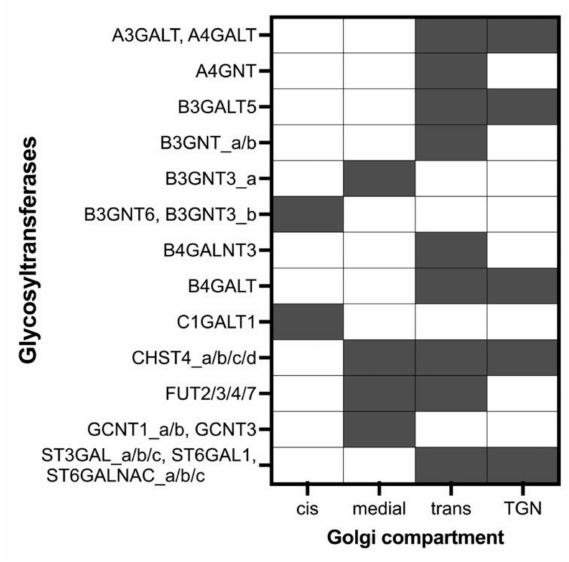
Figure 3. Glycosyltransferase localization across the four Golgi compartments. Filled cells repre- sent the presence of the enzymes in a compartment, while white cells represent enzymes absence. “_a/b/c/d” represent different reactions (reaction rules) for the same